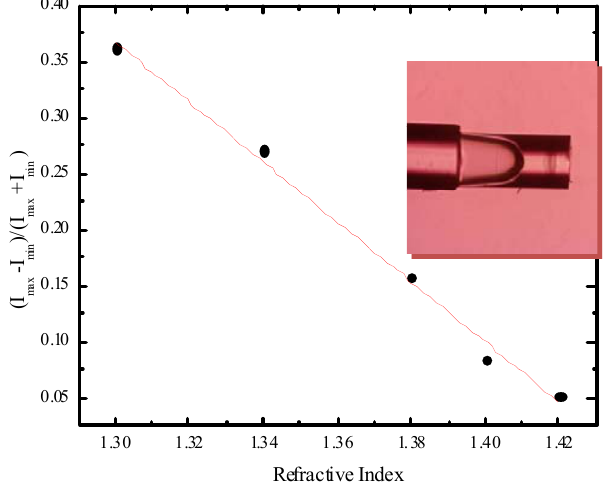
Figure 8. Sensitivity of the sensing head (inset: microscopic image of the sensing